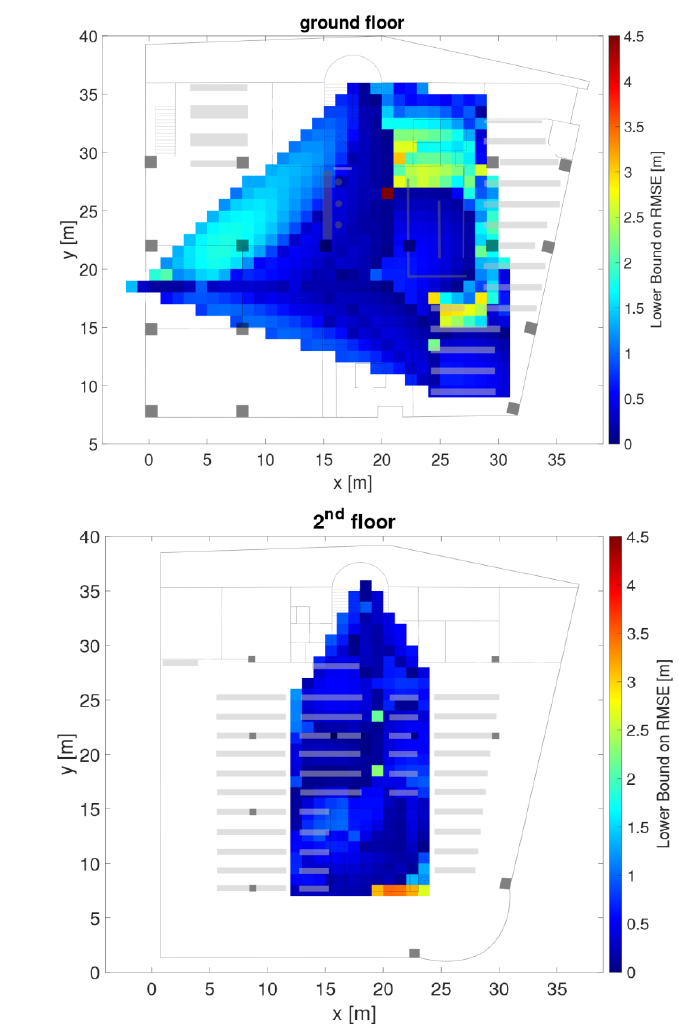
Figure 19. Visualization of the Cramér-Rao Lower Bound (CRLB) on the RMSE for ( a ) the ground and ( b ) the second floor.